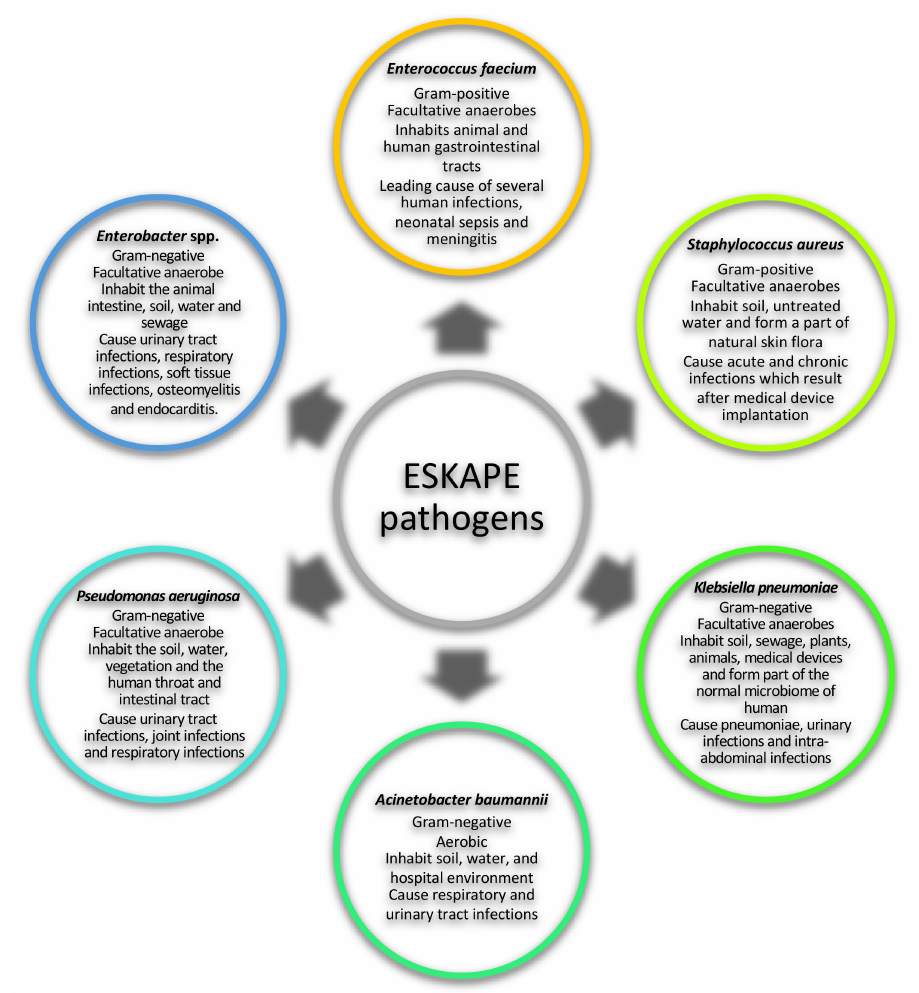
Figure 1. General characteristics ESKAPE pathogens. The ESKAPE group of pathogens consists of